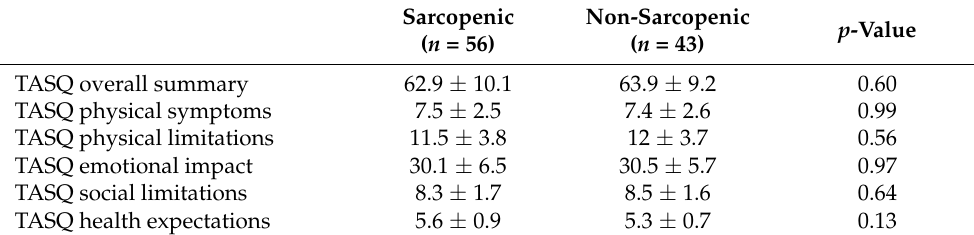
Table 2. Baseline TASQ score of the study population